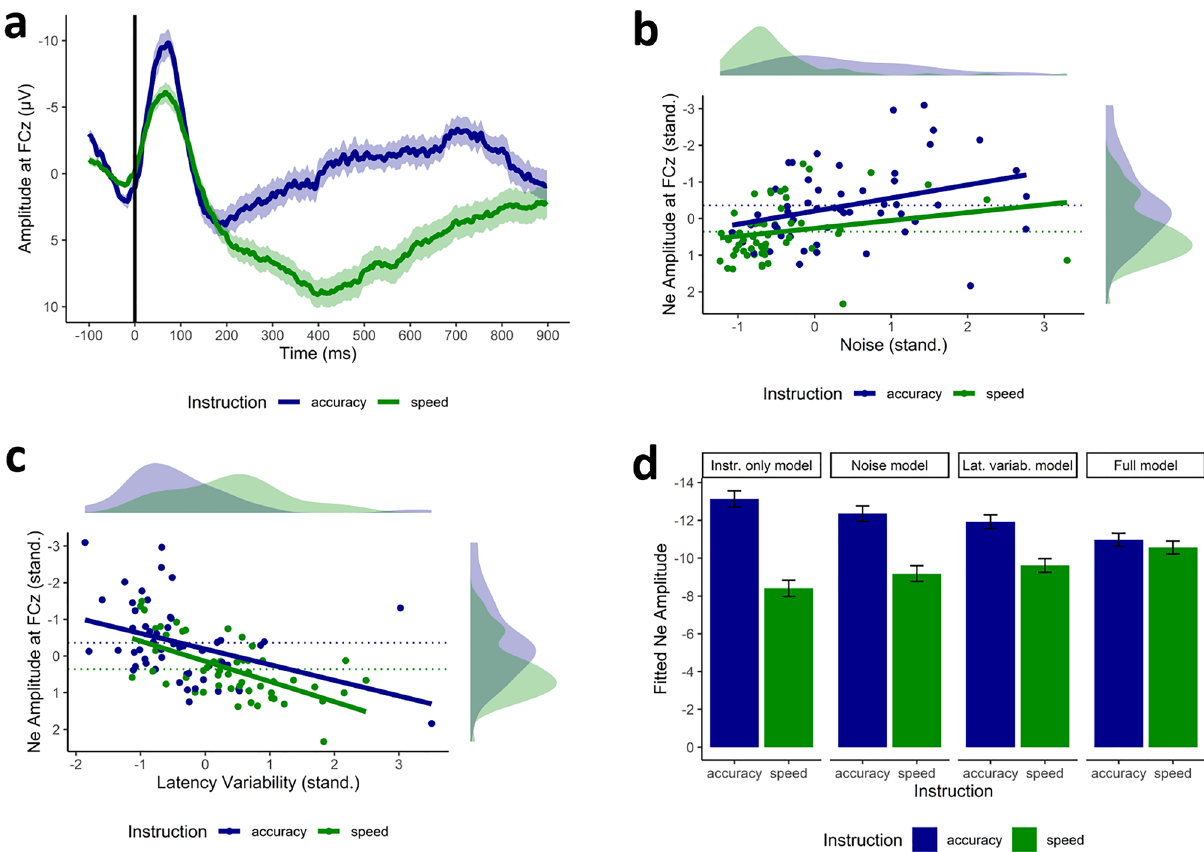
Figure 3. Illustration of the results. Note . ( a ) Grand-average waveform ± standard error of the speed and accuracy condition at the electrode FCz. ( b ) Relationship between the level of standardised noise (x-axis) and the standardised Ne amplitude (y-axis) for the accuracy and speed instruction. ( c ) Relationship between the extent of single-trial latency variability (x-axis) and the Ne amplitude (y-axis) for the accuracy and speed instruction. ( d ) The difference of the Ne amplitude between the accuracy and speed instruction when only considering the instruction (“Instruction only model”), when controlling for the level of noise (“Noise model”), when controlling for the extent of latency variability (“Lat. variab. model”), and when controlling for both noise and latency variability (“Full model”).